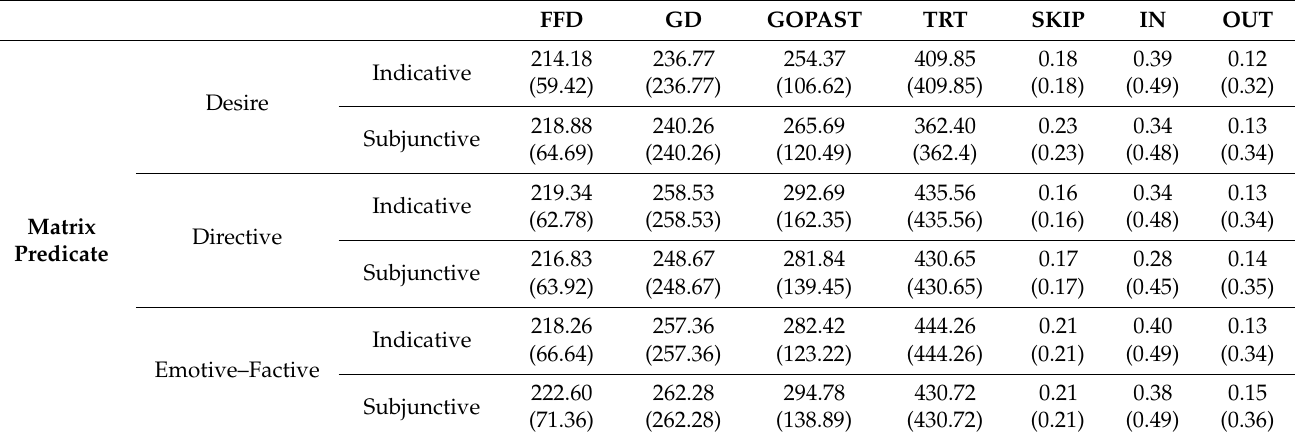
Table 5. Reading time measures for L1